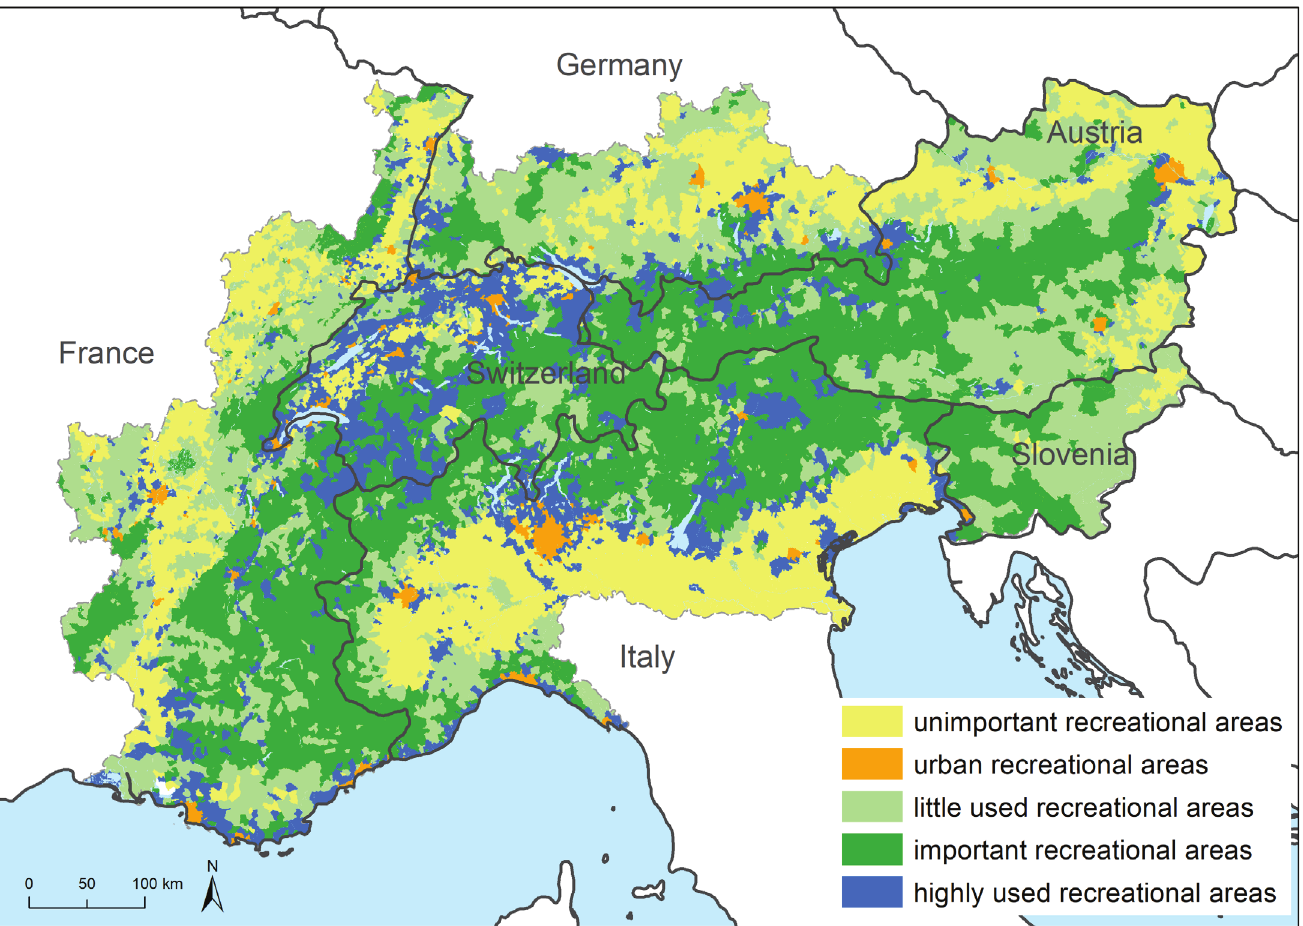
Figure 2. Spatial patterns of supply, demand and actual use of outdoor recreation at the municipality level in the Alpine Space area. From Schirpke et al.